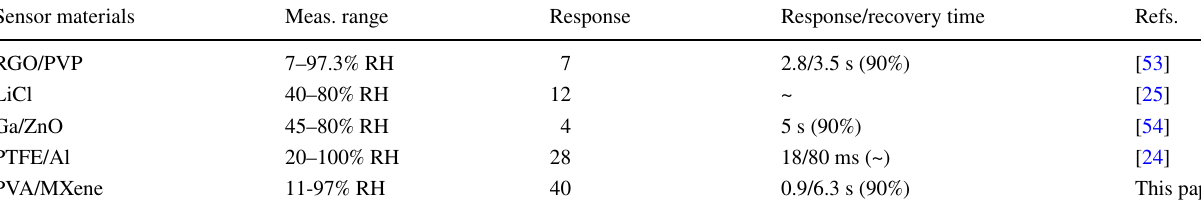
Table 2 Performance of the presented sensor in this work compared with the previous work Sensor materials Meas.